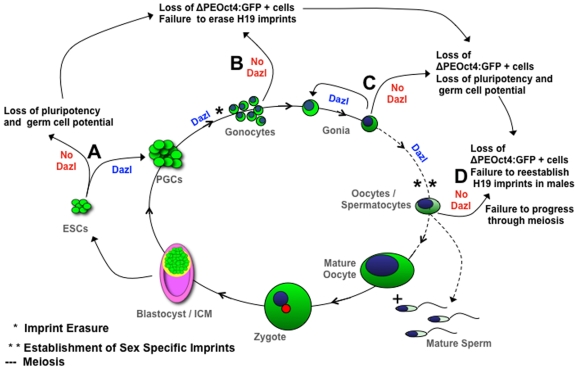
Proposed Model Denotes Dazl as Link Between Pluripotency, Reprogramming and Differentiation in vivo and in vitro.Green signifies Oct4ΔPE:GFP expression during the lifecycle of germ cell development. (A) mESCs derived from Dazl−/− blastocysts display a reduction in pluripotency and germ cell markers, and do not differentiate towards the germ cell lineage as seen in wildtype and Dazl heterozygous mESC lines. (B) Gonocytes in vivo and putative germ cell in vitro show a reduction in Oct4ΔPE:GFP -positive cells, and do not display stage specific genetic markers of germ cell development, or erasure of imprinting methylation marks at the H19 locus in males. (C) Gonia isolated from Dazl−/− mutant gonads show a significant reduction in Oct4ΔPE:GFP -positive cells and aberrant gene expression, indicating a loss of pluripotency, self-renewal, and germ cell potential. (D) Early stage oocytes and spermatocytes from Dazl−/− embryos display a significant loss of Oct4ΔPE:GFP -positive cells, aberrant gene expression, failure to re-establish imprinting methylation marks at the H19 locus in males, and failure progress though meiosis.